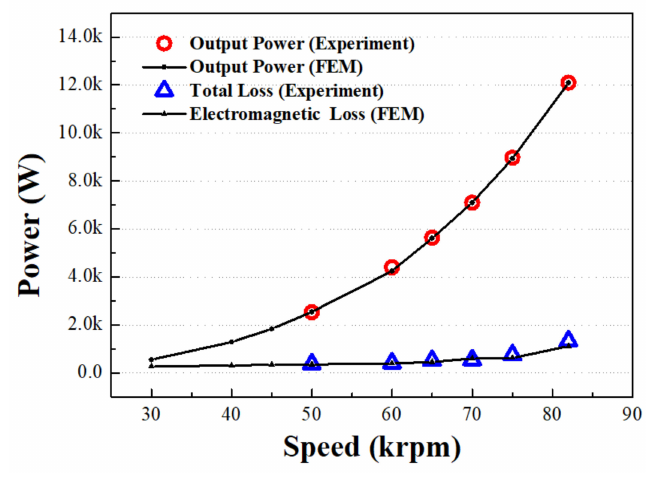
Figure 12. Load experiment results for concentrated